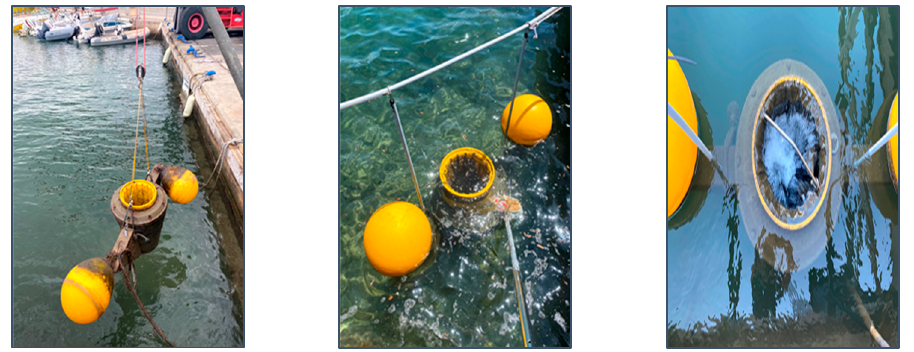
Figure 4. Seabin device installed in reffering ports.